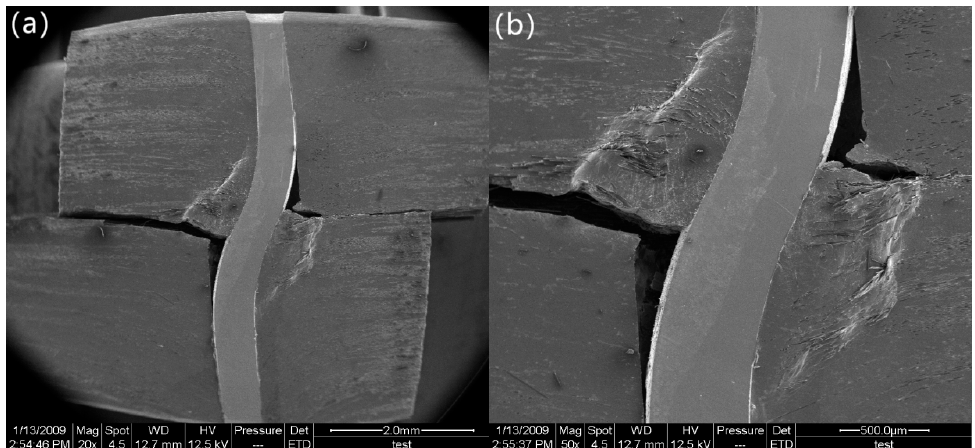
Figure 6. Morphology of the specimen when the matrix is deformed: ( a ) deformed z-pin at low magnification, ( b ) deformed z-pin at high magnification, ( c ) deformed matrix at low magnification, and ( d ) deformed matrix at high magnification.